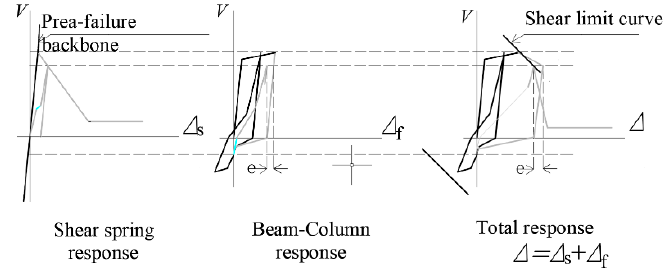
Figure 3. Hysteretic curve of shear – bending interaction model [17].